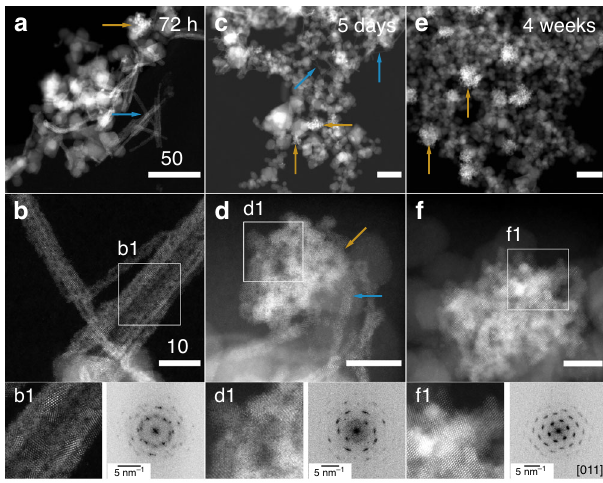
Fig. 4 Scanning transmission electron micrographs of U-magnetite samples. High-angle annular dark- fi eld scanning transmission electron microscopy images of U-magnetite samples were obtained (scale bar 50 nm a , c , e ; 10 nm b , d , f ). a , b 72-h Sample; c , d 5-day sample; e , f 4- week sample. Blue arrows point to UO 2 nanowires, whereas orange ones point to UO 2 nanoclusters. In b , d , and f , the white squares represent the area that is magni fi ed in panel b1 , d1 , and f1 , where the corresponding Fast Fourier Transform (FFT) was acquired. b1 Nanocrystals that form nanowires with corresponding FFT showing random orientations. d1 Nanoclusters formed by similar size nanoparticles with FFT that starts to show texture. The blue and orange arrows point to the nanowires and a connected nanocluster, respectively. This particular morphology suggests that the nanowires collapse into the nanocluster. f1 Nanoclusters formed by larger nanoparticles, with FFT that reveals all particles have the same orientation (in this case, the [011] zone axis). The streaks in FFT show slight misorientation between the